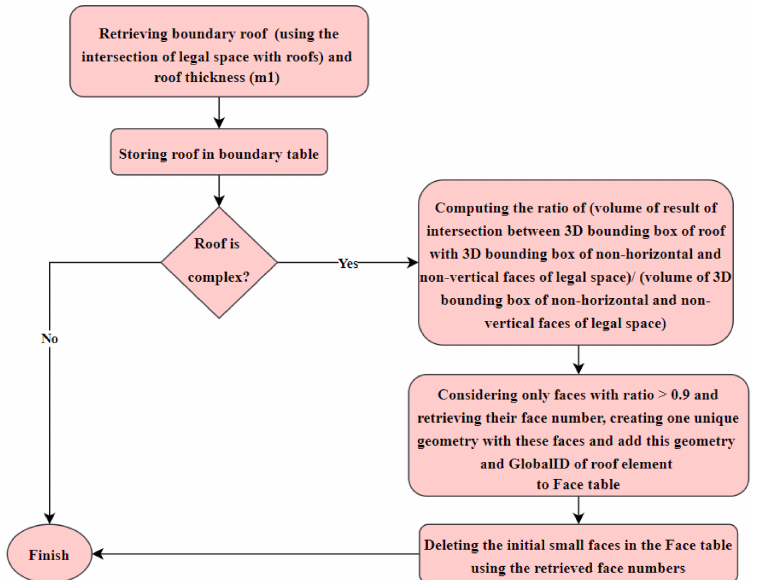
Figure 8. A procedure for converting all the small faces associated with a roof element to a single geometry. It should be noted that for vertical and horizontal faces of legal space, the volume of the bounding box is zero, and they are not associated with any complex building